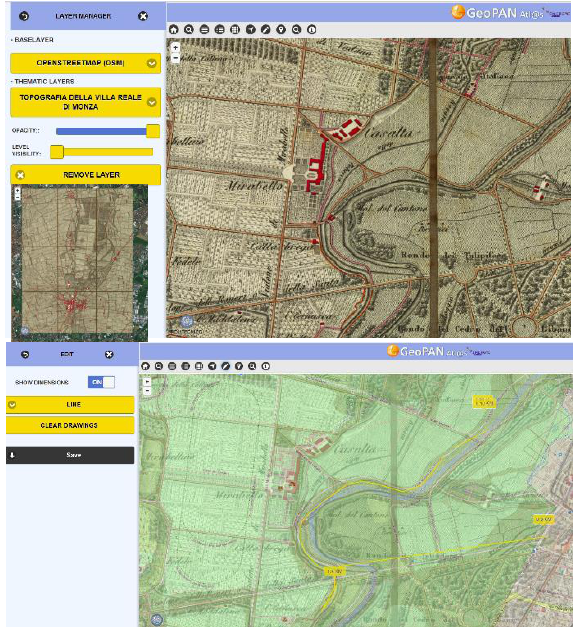
Figure 6. The navigation of the Brenna’s Map and the comparison with the current state of the art (Open Street Map), through the transparency percentage. A sample of the edit tool supporting itinerary map that can be sketched on-or off-site. The semantic based search tool allows to perform queries across Europe without borders, by integrating keywords within the metadata description supporting the Hub data management